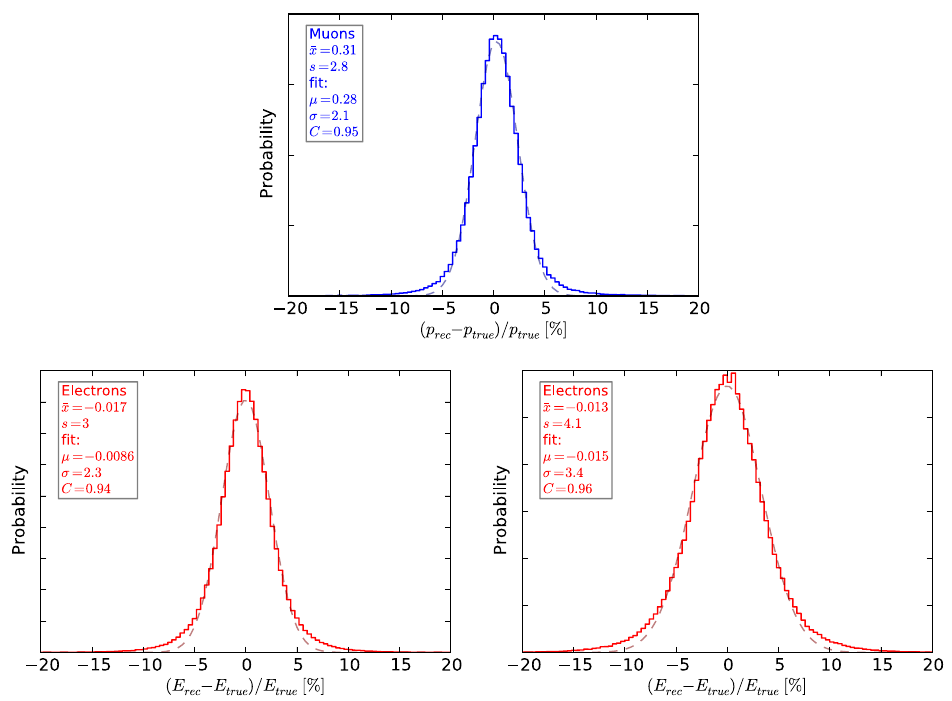
FIG. 8. Detector momentum resolution for muons (top) and electrons (bottom left: 25 GeV; bottom right: 10 GeV neutrino factory) for leptonic events. Gaussian fits are shown with dashed lines. The sample mean, standard deviation, and fit parameters are shown in the upper left